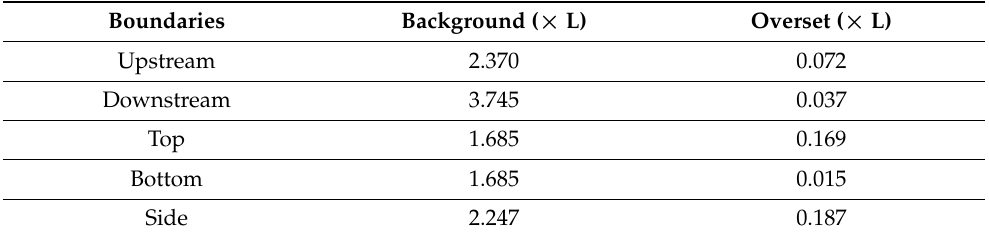
Table 2. Domain dimensions in CFD simulations.